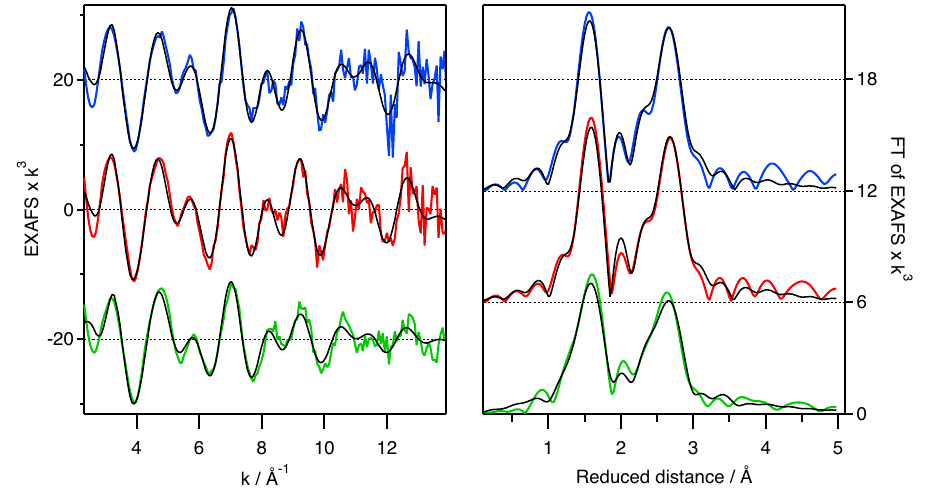
Figure 4. EXAFS (k 3 -weighted) of [Fe II (CN) 6 ] 4− (blue), [Fe III (CN) 6 ] 3− (red), ox-ferri (green). Data offset for clarity. Simulated spectra for DFT-optimized structures plotted in black lines, with the ox-ferri simulation based on the cis-[Fe III (CN) 4 (CH 3 CN) 2 ] 1− isomer with C 2v symmetry. Fit parameters are given in Table